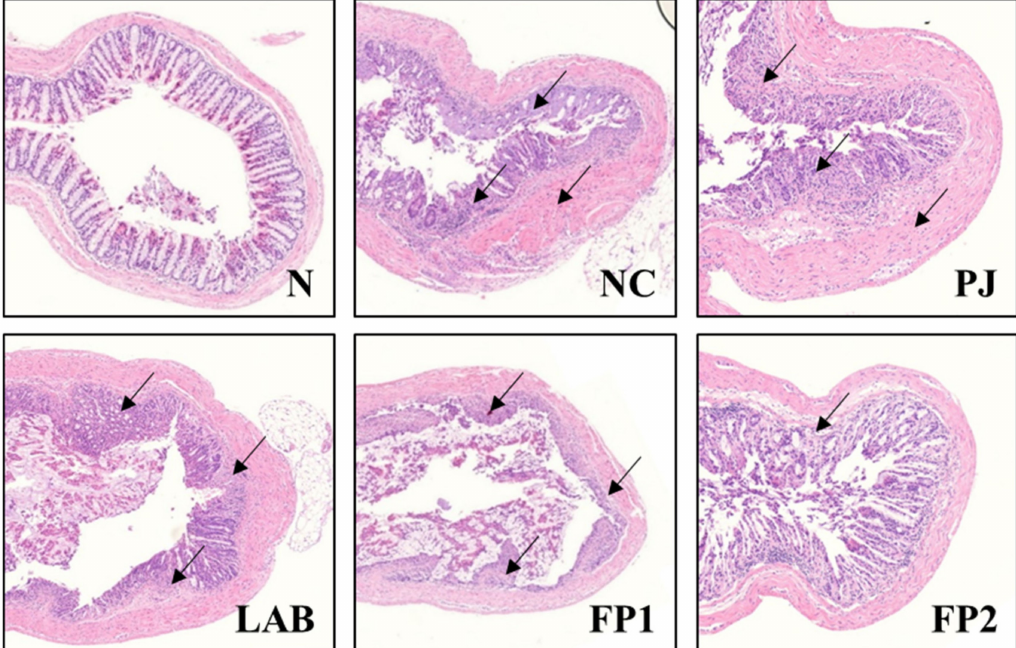
Figure 5. Effects of FP on H&E-stained histological changes in colonic tissue to DSS-induced colitis mice. Arrows indicate damages on colonic tissues such as inflammatory cell infiltrates and epithelial erosions. Magnification: × 100. N, normal group, non-DSS treatment; NC, negative control group, DSS treatment and supplementation with distilled water; PJ; Prunus mume juice (PJ) group, DSS treatment and supplementation with 200 mg/kg of 2.5% PJ; LAB, lactic acid bacteria (LAB) group, DSS treatment and supplementation with 200 mg/kg of L. plantarum and L. casei suspended by distilled water; FP1, low dose of fermented Prunus mume juice (FP) group, DSS treatment and supplementation with 100 mg/kg of FP; FP2, high dose of FP group, DSS treatment and supplementation with 200 mg/kg of